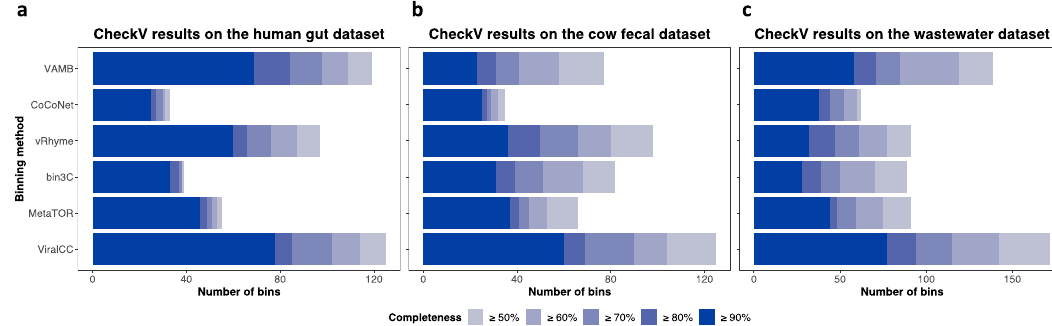
Fig. 3 | ViralCC outperforms other binners onreal metagenomicHi-C datasets. Comparisonofdraftviralbinsretrievedbydifferentbinningtoolsaccordingtothe CheckV completeness standard on the ( a ) human gut, ( b ) cow fecal, and ( c )